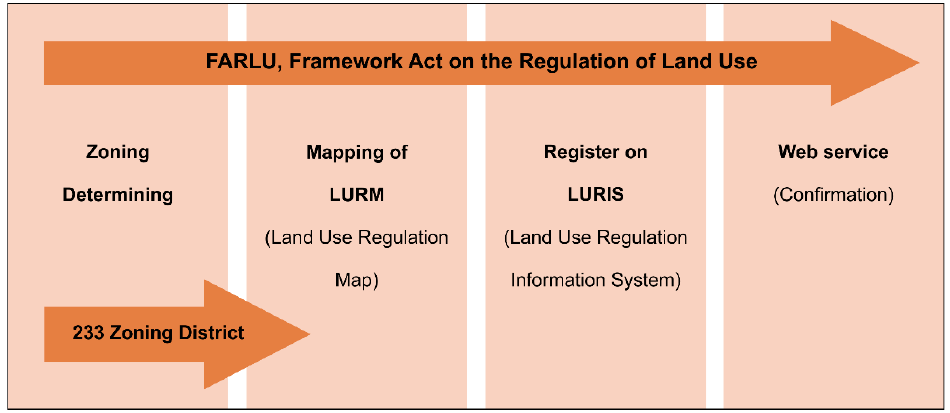
Figure 4. Notification process of the land use regulation map (LURM). Source: Ministry of Land Infrastructure and Transport [74].